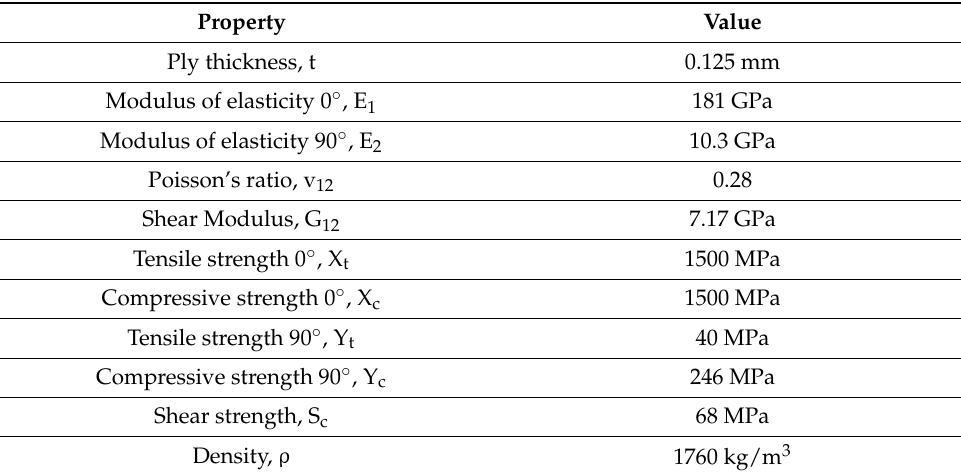
Table 6. Composite material T300/5208’s mechanical